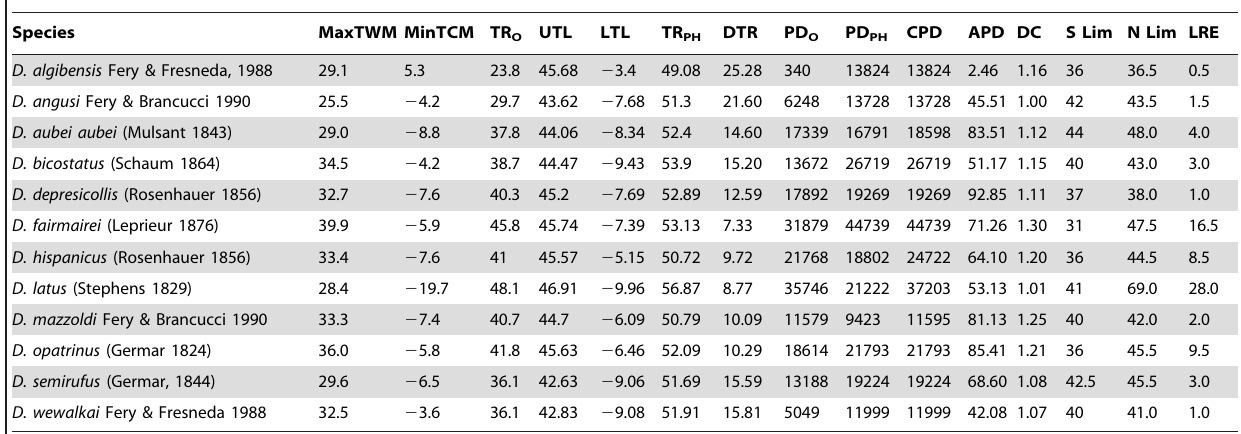
Table 1. Values of thermal tolerance, size of potential distribution, geographical range and dispersal capacity for the considered